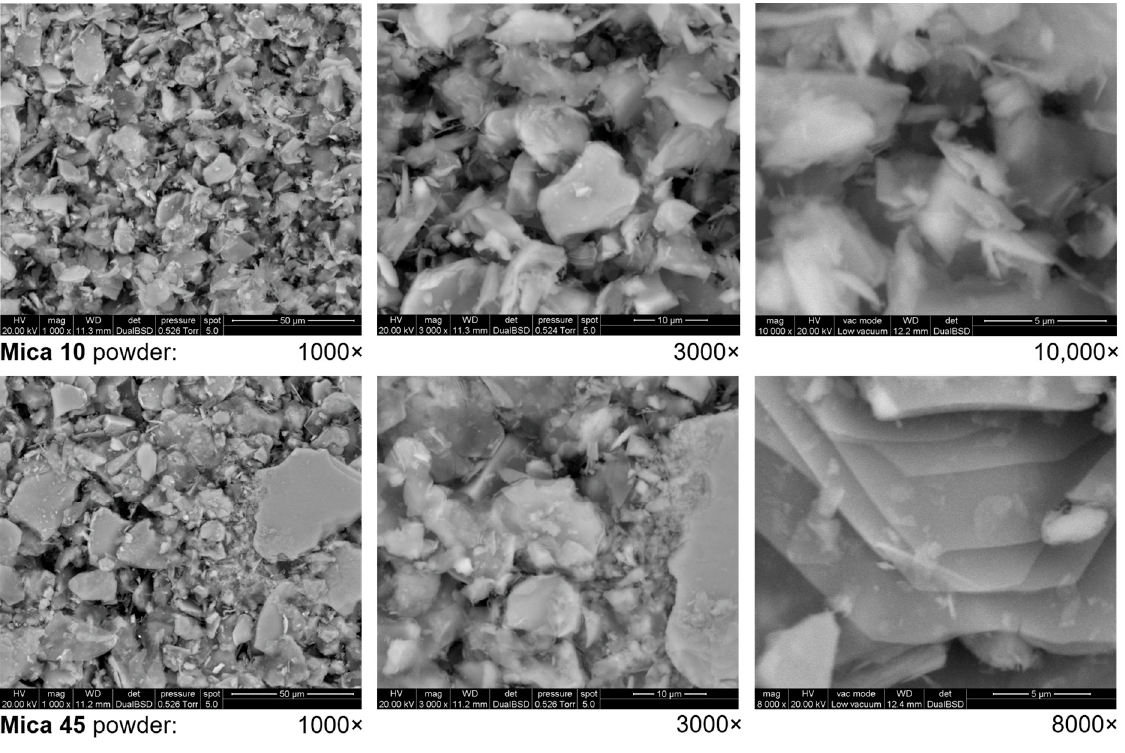
Figure 2. ESEM images of Mica 10 and Mica 45 at different magnifications.